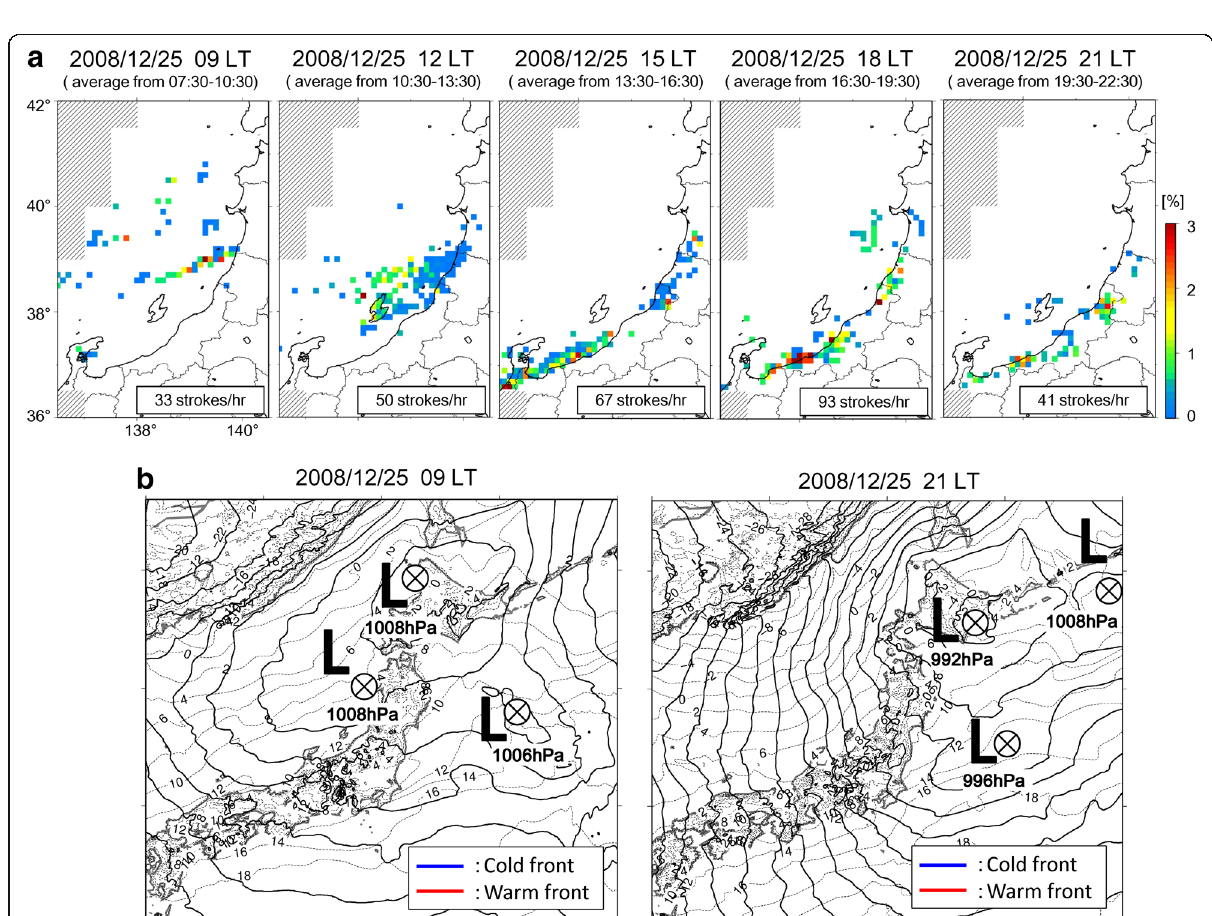
Fig. 13 a , b Similar to Fig. 10 but for case